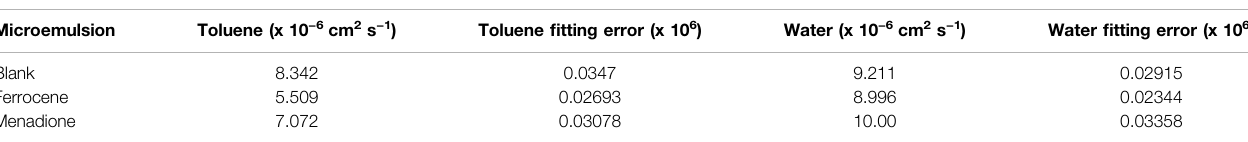
TABLE 1 | NMR diffusivities for SDS